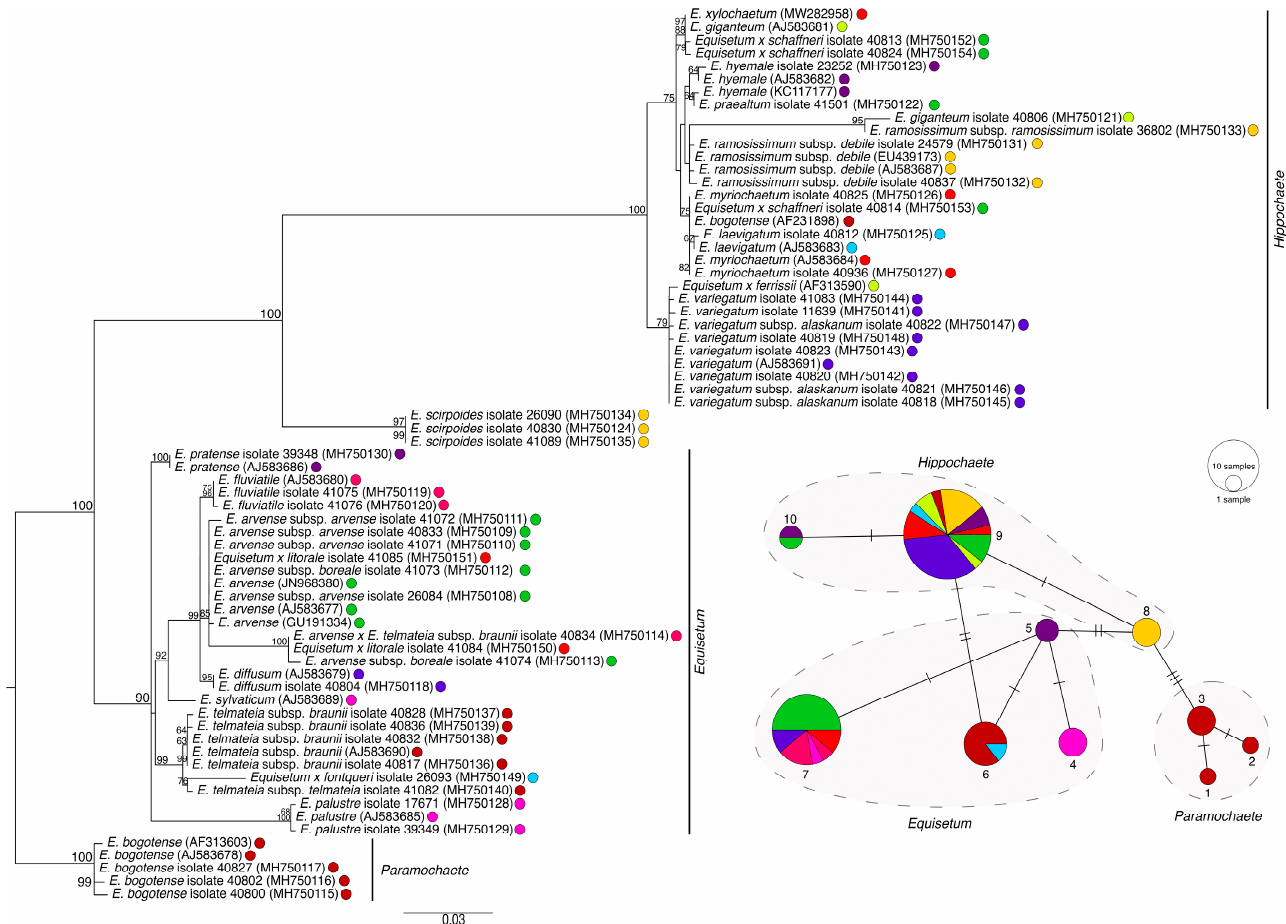
Figure 6. Phylogenetic estimation and TCS network of Equisetum rps4 sequences. The scale bar of the tree represents the estimated number of nucleotide substitutions per site. The maximum-likelihood bootstrap values are reported at the respective nodes. The colours of taxa present in the tree correspond with the colours in the TCS haplotype map. The size of the circle represents the number of the taxa that share the same haplotype.